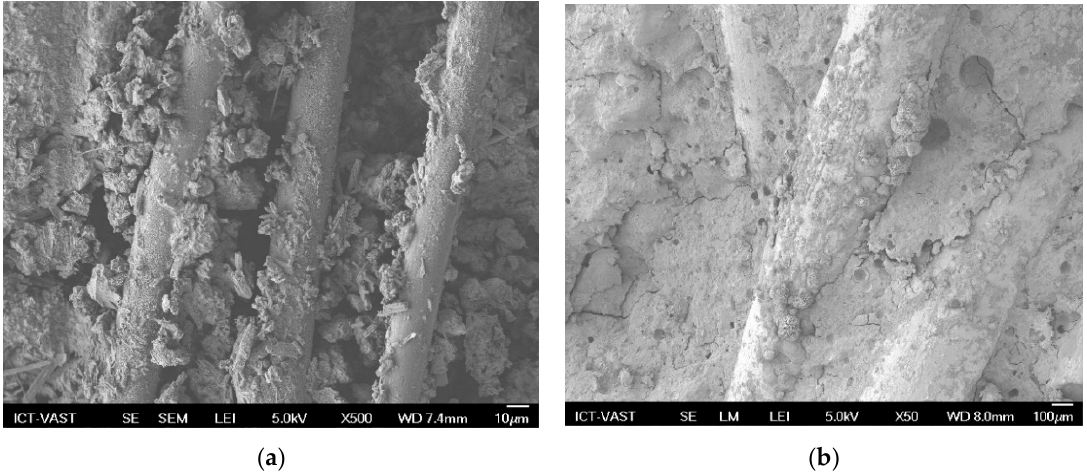
Figure 21. SEM photos. ( a ) Specimen with polypropylene fiber; ( b ) specimen with steel fiber.